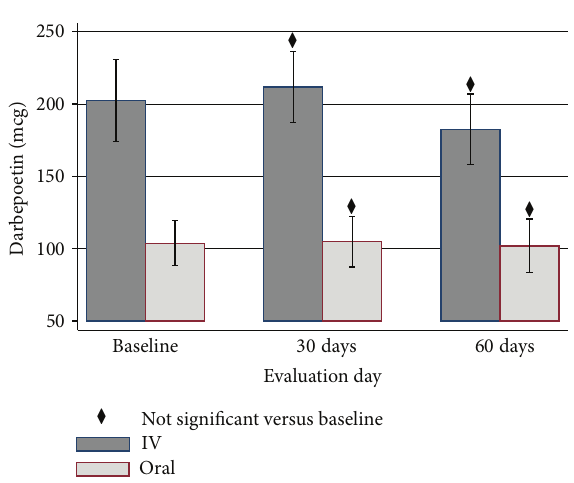
Figure 3: Mean transferrin saturation (TSAT) ± SD levels by treatment group over duration of study. 𝑃 values compare 30 and 60 days to baseline values for the IV group.